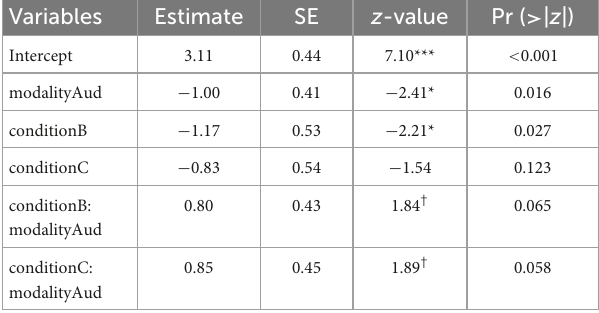
TABLE 6 Results of GLME model analysis of accuracy rates in the semantic transparency